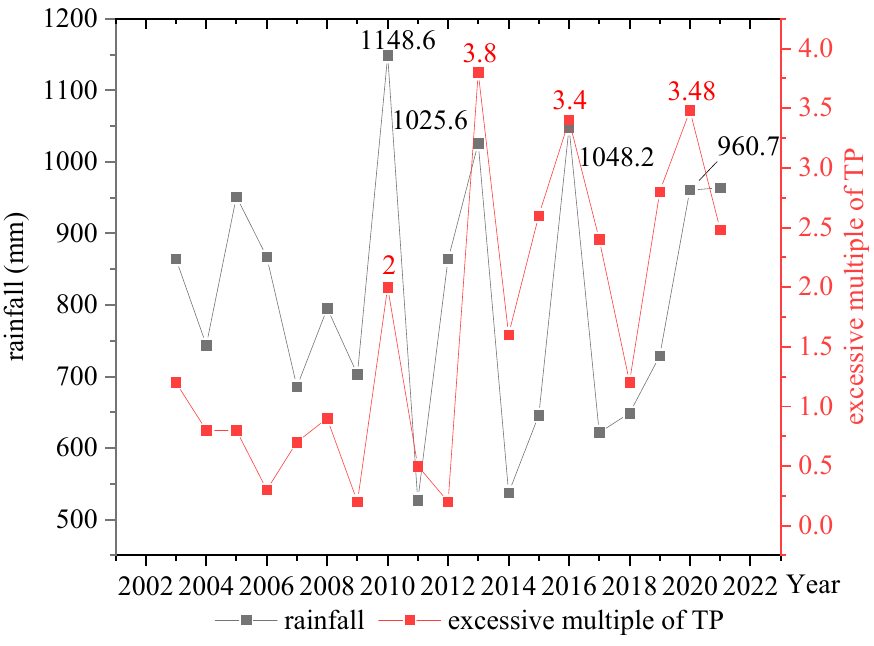
Figure 5. Relationship between rainfall and excessive multiples of TP in the Beizamu section. ( Note: the rainfall data were from 1 January 2003 to 9 November 2021).